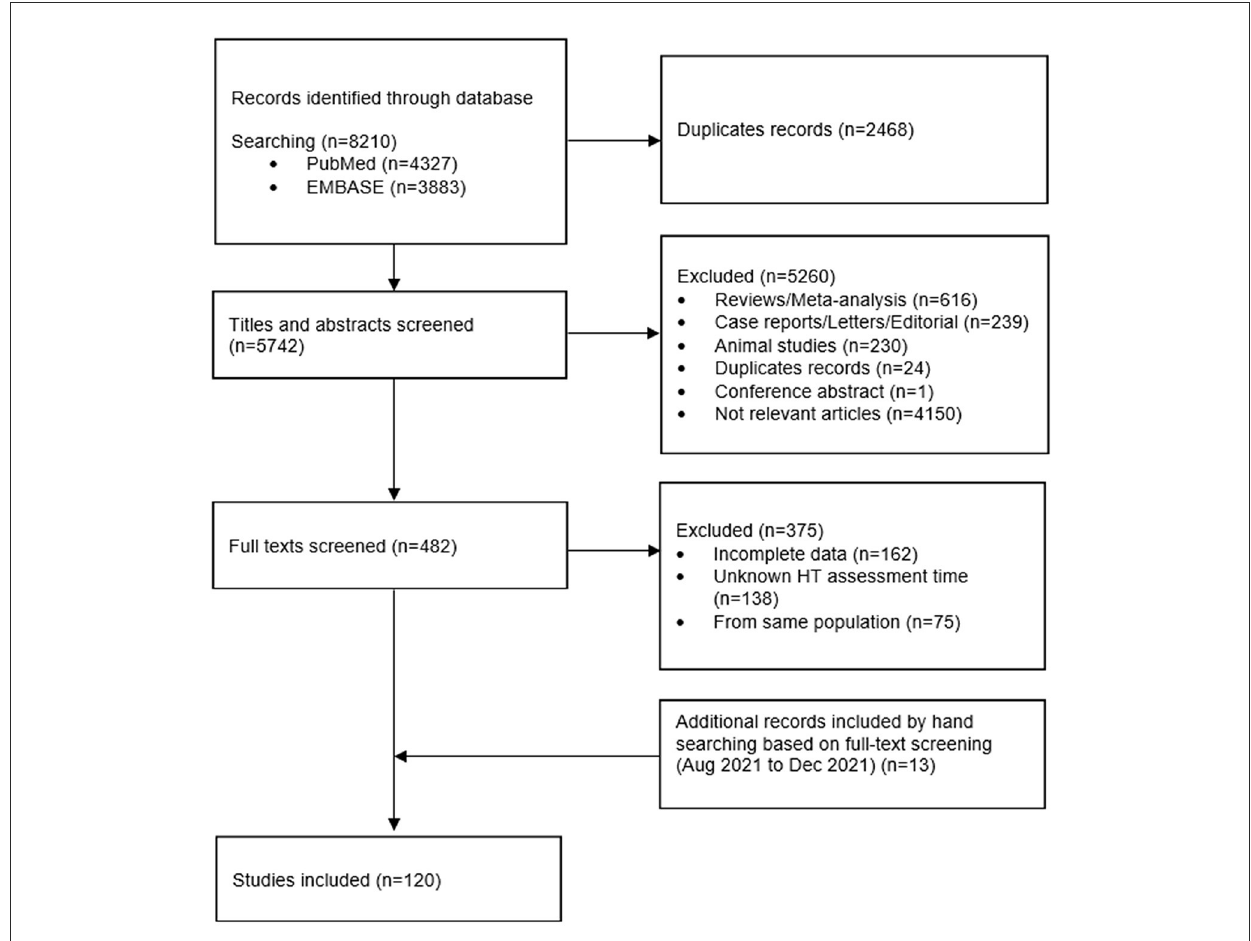
FIGURE1 Screening flow